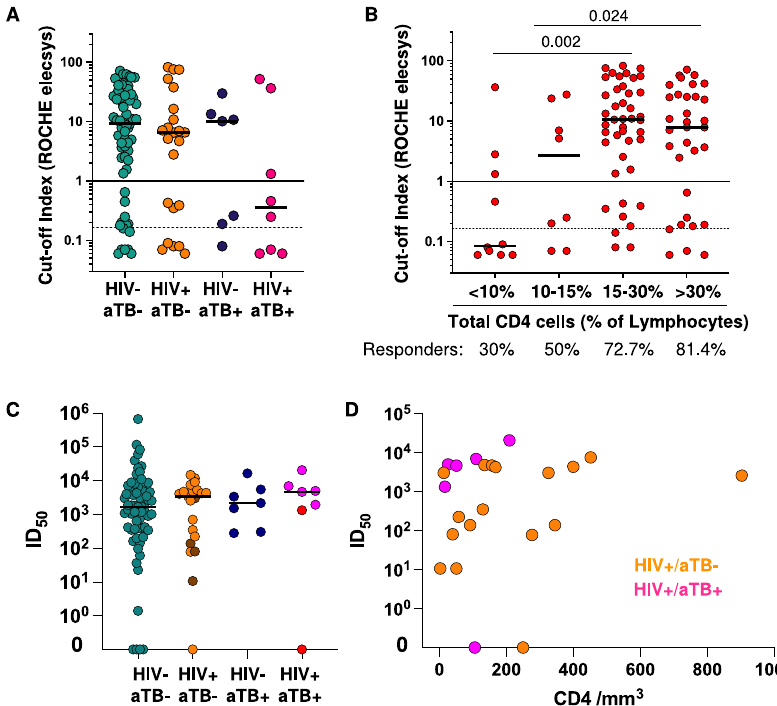
Fig. 4 | Serum anti-nucleocapsid IgG levels in n =104 COVID-19 patients in relation to the presence of HIV-1 and/or tuberculosis co-infection. A Although no signi fi cantquantitative differenceincut-off indexwasobserved by HIV-1 and or tuberculosis status, 8/15 tuberculosis patients in total and 5/8 with HIV-1 and tuberculosis were below threshold for positivity of 1.0. The >1 cut-off value represents the manufacturer ’ s cut-off. The >0.165 cut-off value represents the optimal cut-off value de fi ned by ROC curve analyses on 197 participants that improved the performance of the test to give a sensitivity of 100% (95%CI: 94.0- 100%) 57 . B There was a signi fi cant trend towards decreased antibody levels in